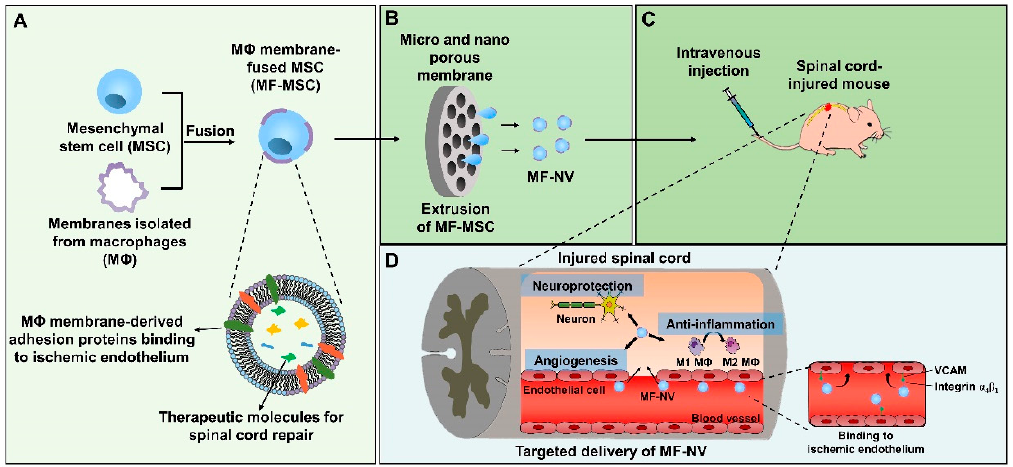
Figure 1. Schematic diagrams for the fabrication and therapeutic e ff ects of macrophage membrane-fused exosome-mimetic nanovesicles (MF-NVs) for spinal cord repair. ( A ) The preparation of MF-mesenchymal stem cells (MSC) through the fusion of macrophage (M Φ ) membranes into MSCs. MF-MSCs contain the membrane proteins of M Φ and the therapeutic molecules. ( B ) Production of MF-NVs from MF-MSCs by serial extrusion. ( C ) Intravenous injection of MF-NVs into the spinal cord-injured mouse. ( D ) The mechanisms of targeting and therapeutic e ff ects of MF-NVs on spinal cord injury (SCI) mice model.